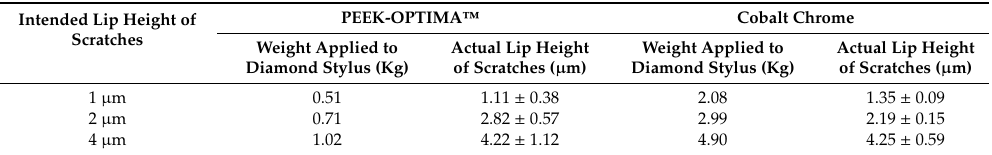
Table A1. Load applied to a 200 µ m radius diamond stylus to create scratches of a known geometry in PEEK and cobalt chrome